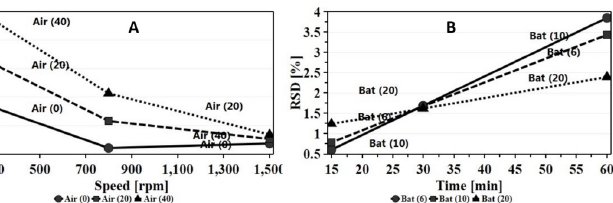
Fig 13. Interaction effect plot of (A) air flow with increasing speed (B) batch size with increasing processing time on content uniformity while other factors were maintained at their middle values.